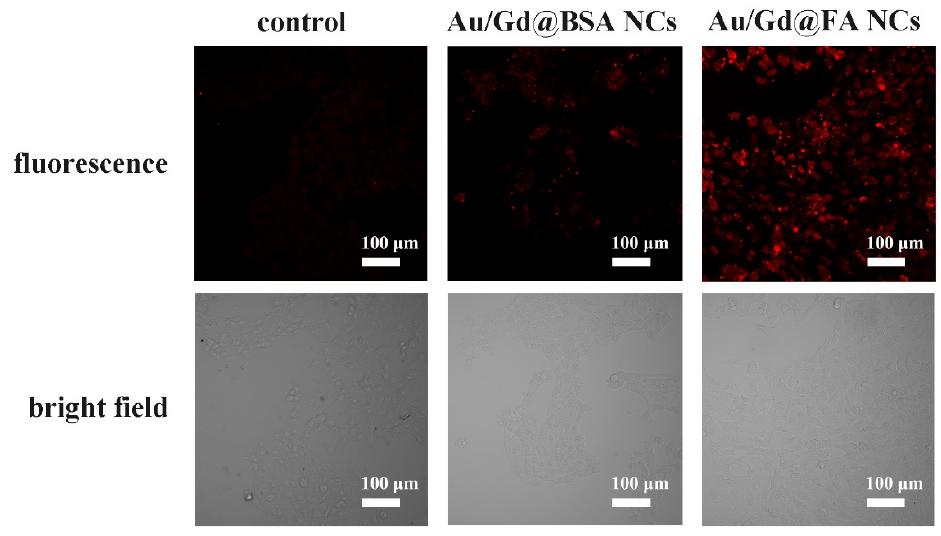
Figure 4. Confocal near-infrared fluorescence images of 4T1 cells after 6 h treatment with PBS, Au/Gd@FA NCs (60 μ g/mL) and Au/Gd@BSA NCs (60 μ g/mL) at 37 °C.